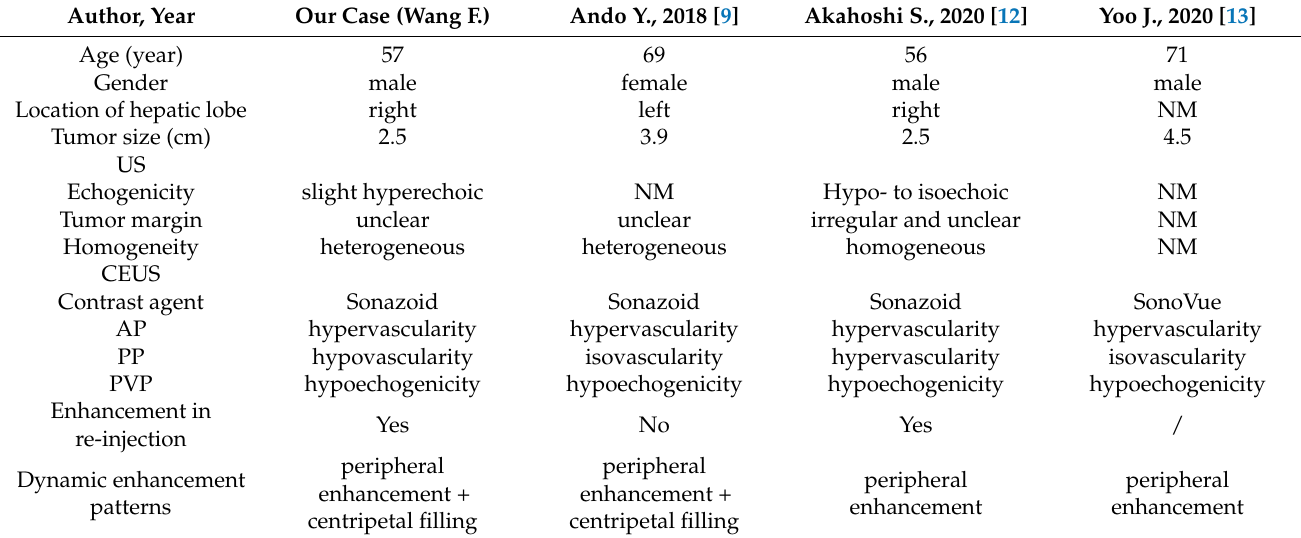
Table 1. CEUS characteristics of three patients with HSH 1